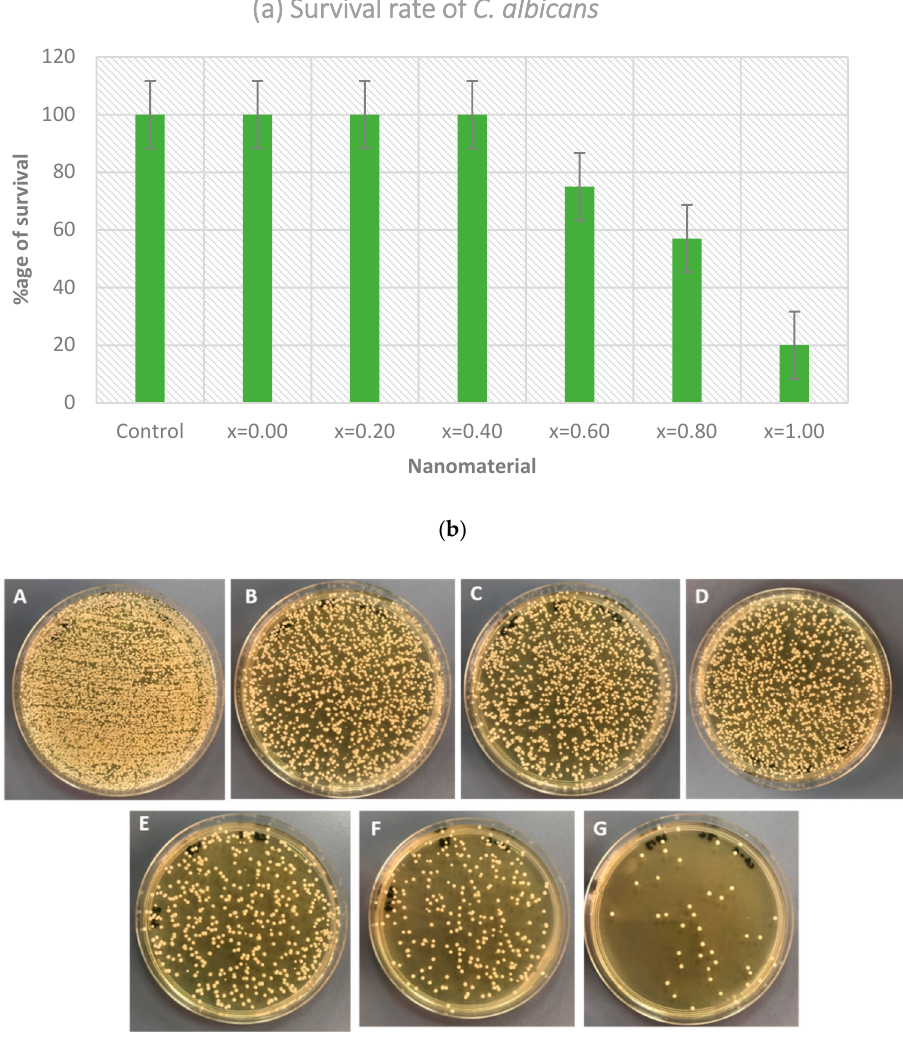
Figure 6. ( a ) Survival rate of C. albicans after the treatment with Co 0.5 Ni 0.5 Ga x Fe 2 − x O 4 (0.0 ≤ x ≤ 1.0) MCs ( p < 0.001); ( b ) Agar plates showing the CFU count of C. albicans after the treatment with Co 0.5 Ni 0.5 Ga x Fe 2 − x O 4 MCs: ( A ) untreated; ( B ) x = 0.0; ( C ) x = 0.20; ( D ) x = 0.40; ( E ) x = 0.60; ( F ) x = 0.80; ( G ) x = 1.0.